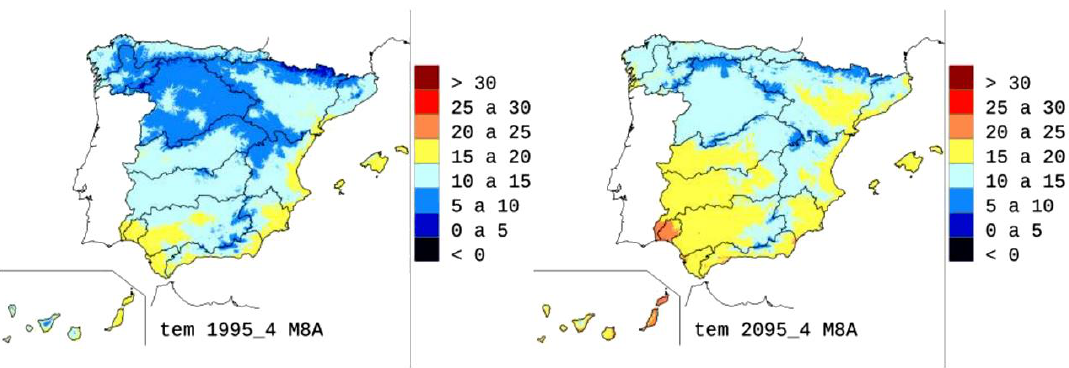
Figure 3. Projections of change in daily mean temperature (°C) from April 1995 to April 2095 in Spain (Source: CEDEX, 2017 [137]).